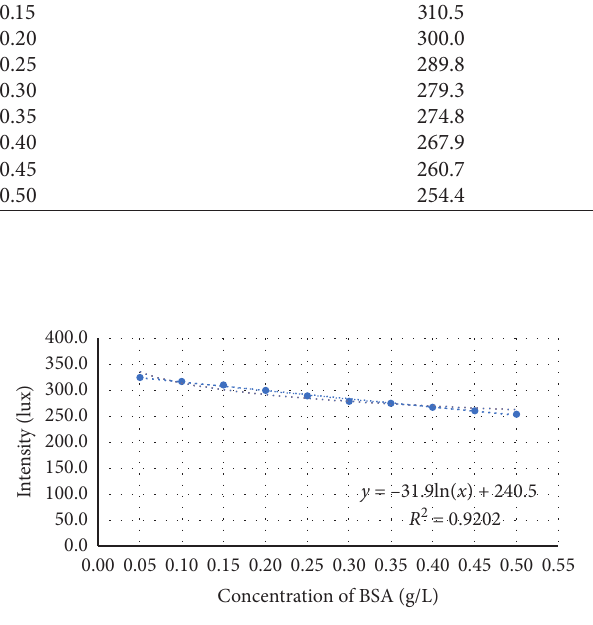
Figure 5: Calibration curve of UV intensity penetrating through known BSA samples. Table 2: Absorbance of known BSA-normal saline solutions measured by a smartphone.